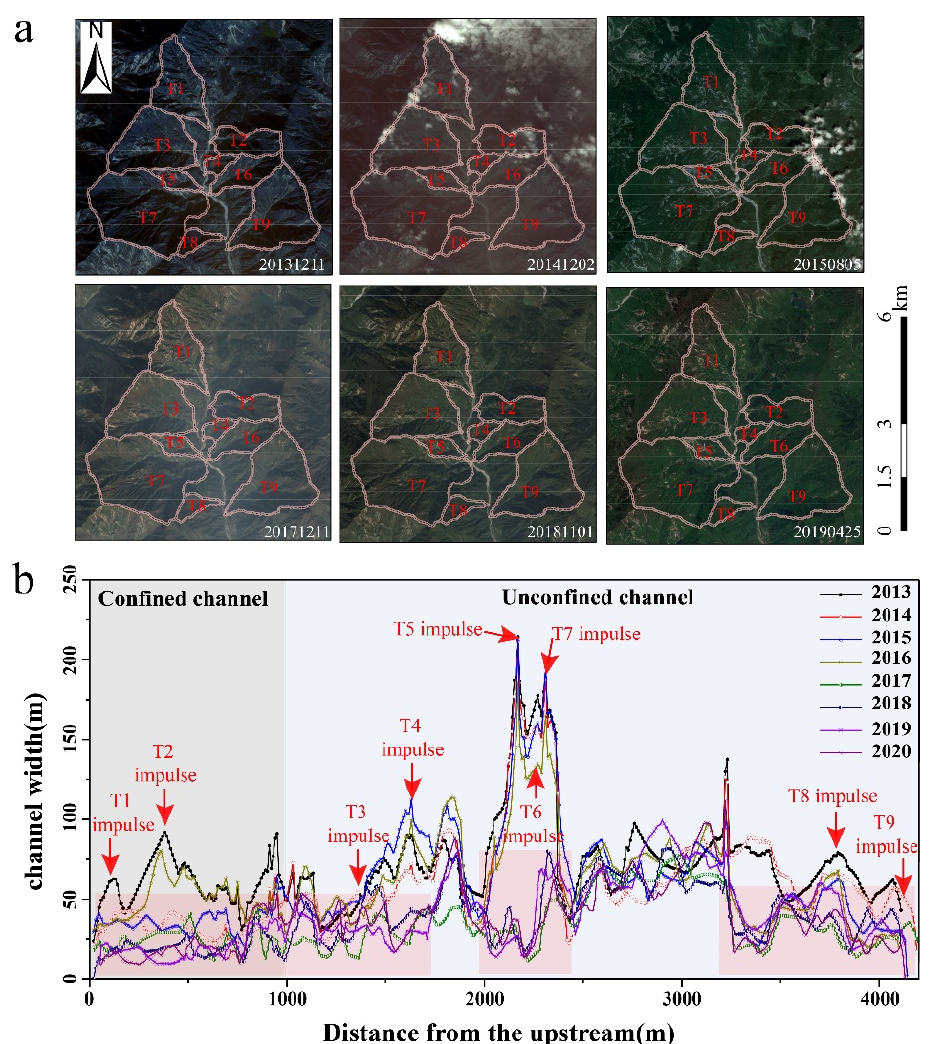
Figure 9. Change of the land cover and channel width of Longxi River after the debris flow events occurred on 8 August 2013. ( a ) shows the series Sentinel-2 images in study reach (https://glovis.usgs. gov/app, accessed on 29 November 2022), from which the channel width was obtained by visual interpretation; ( b ) shows the change of channel width in different period along the